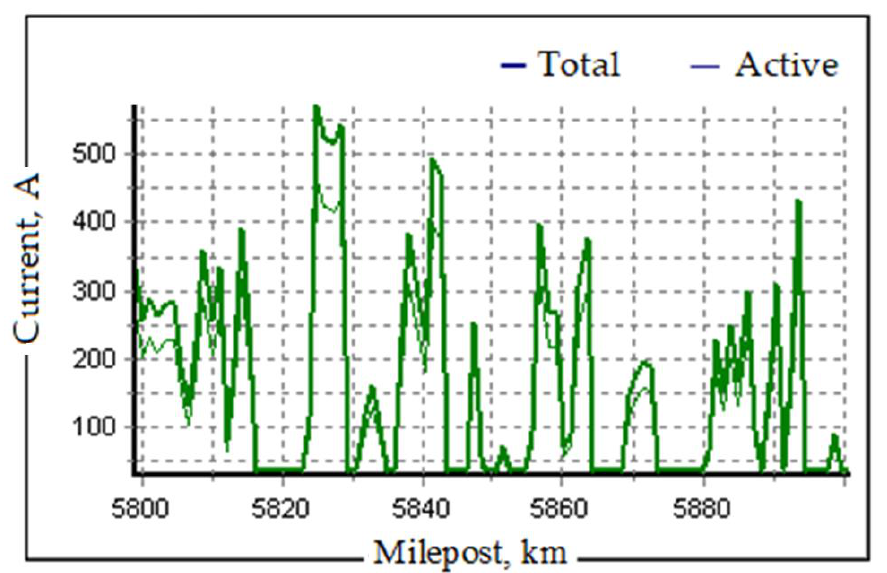
Figure 15. Current profile of a train weighing 5000 tons.